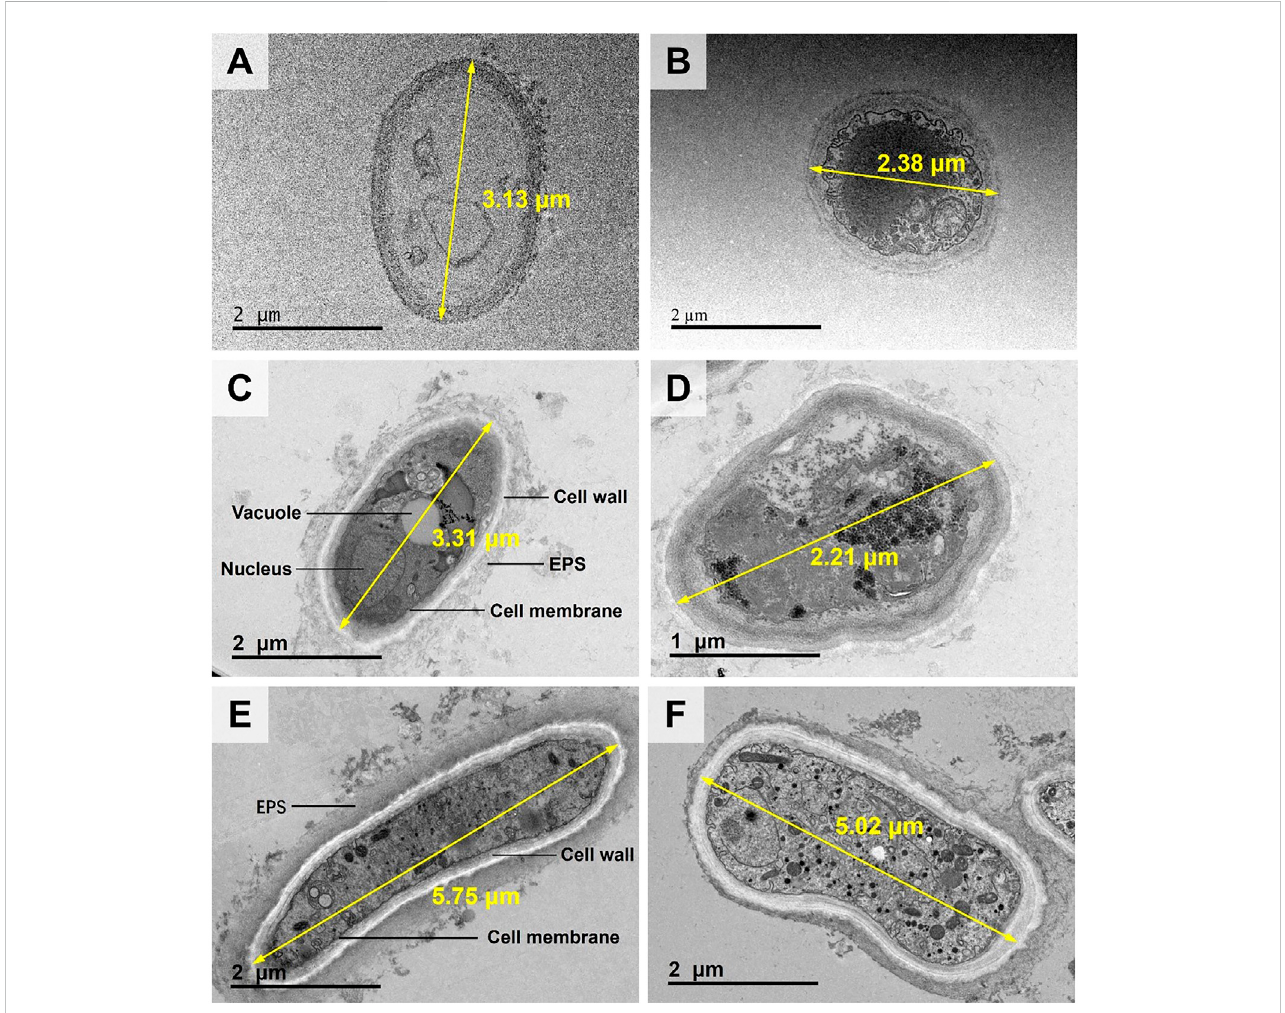
The TEM images of morphological changes of Aspergillus niger after 5 days incubation in the CK (A, B) , TPb (C, D) , and TCd (E, F) treatments. Cell diameters of representative cells were